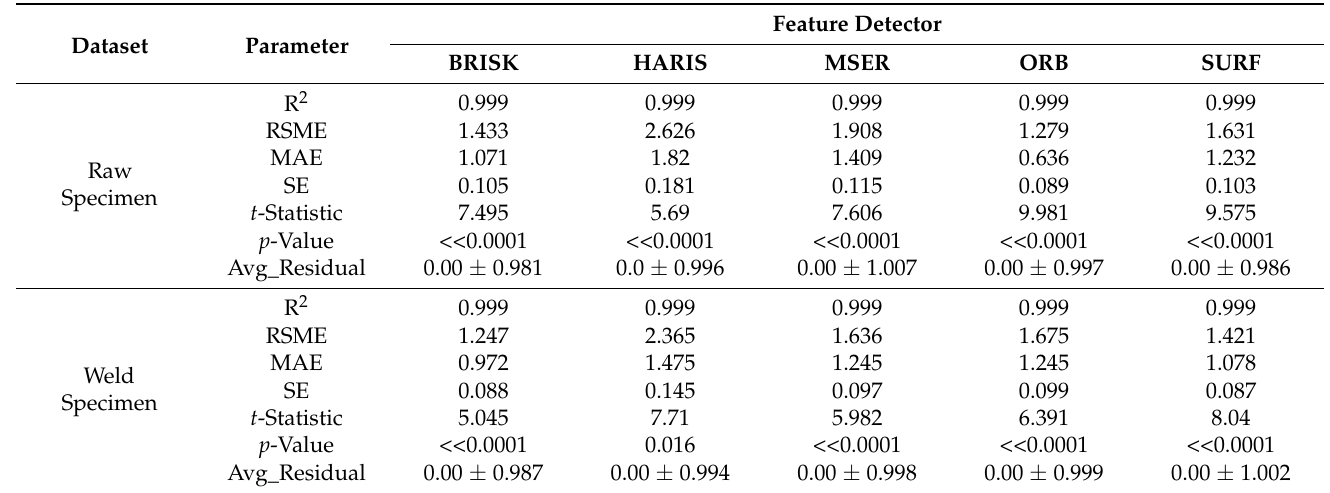
Table 2. Comparison of the image-matching performance using linear regression model analysis from five FD methods on raw and weld datasets: BRISK, HARIS, MSER, ORB, and